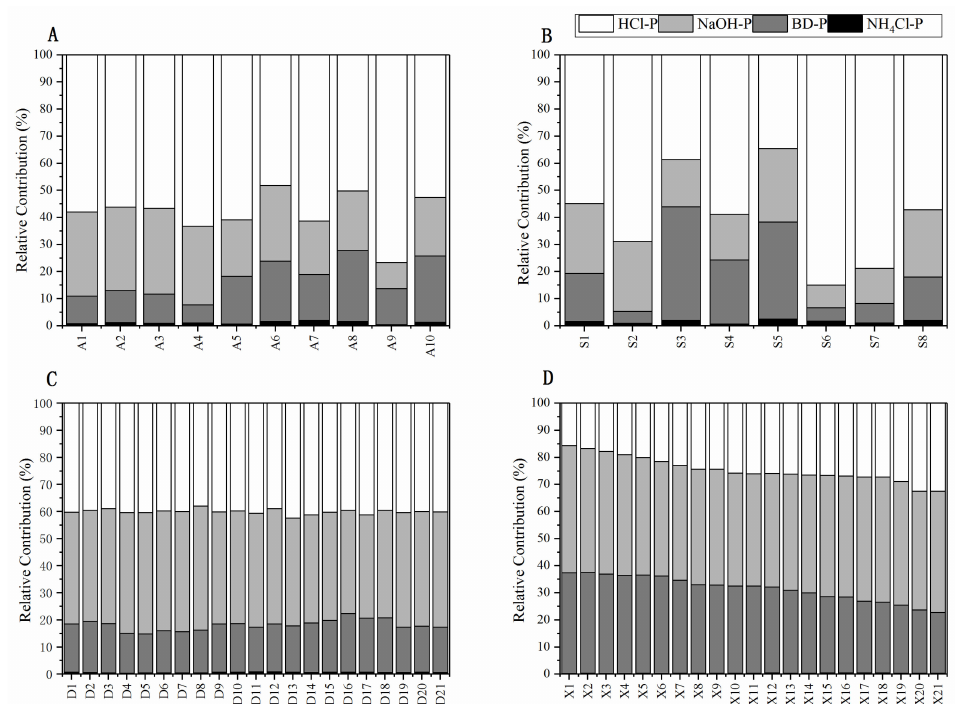
Figure 4. The relative contribution of di ff erent P fractions to inorganic phosphorus (IP) in di ff erent sediments of rivers: ( A ) Anhe, ( B ) Suihe, ( C ) Dongtiaoxi, and ( D )